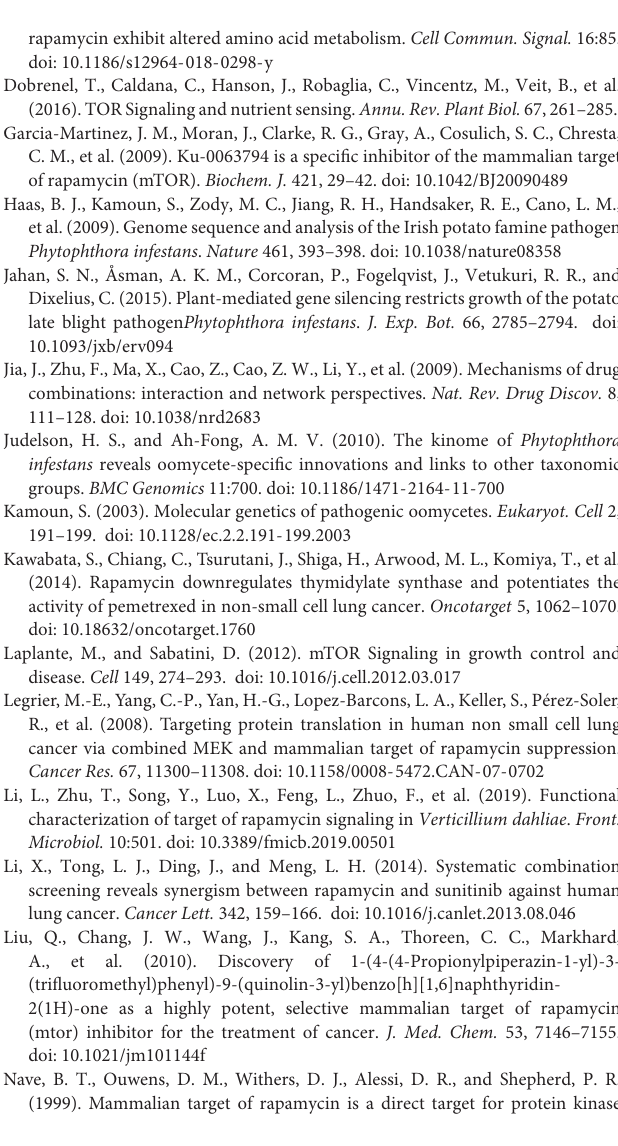
metabolic process, (E) organonitrogen compound biosynthetic process, (F) organonitrogen compound metabolic process, (G) peptide biosynthetic process, (H) peptide metabolic process, (I) translation, (J) structural constituent of ribosome and (K) RNA binding. Supplementary Table 9 | Top 30 KEGG pathways in (A) RAP, (B) AZD and (C) RAP + AZD samples. (D) 14 co-existing KEGG pathways in RAP, AZD and RAP + AZD samples. Supplementary Table 12 | Synergistic effects on pathogenicity-related